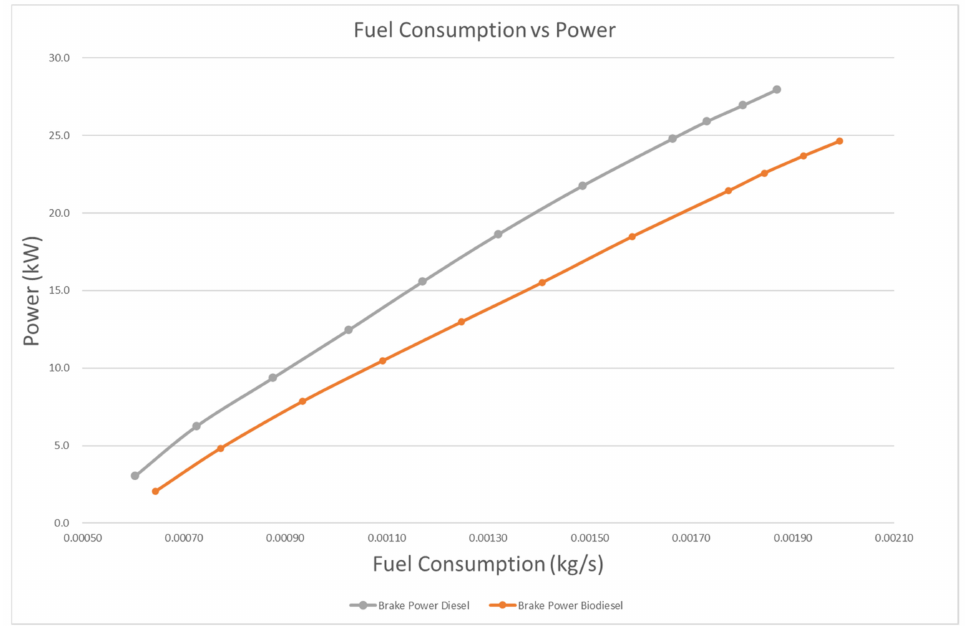
Figure 15. Power vs. fuel consumption.